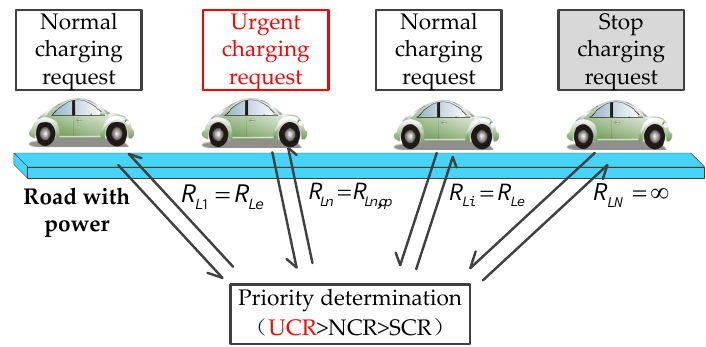
Figure 7. Communication of charging requests and control order of an on-road charging system.